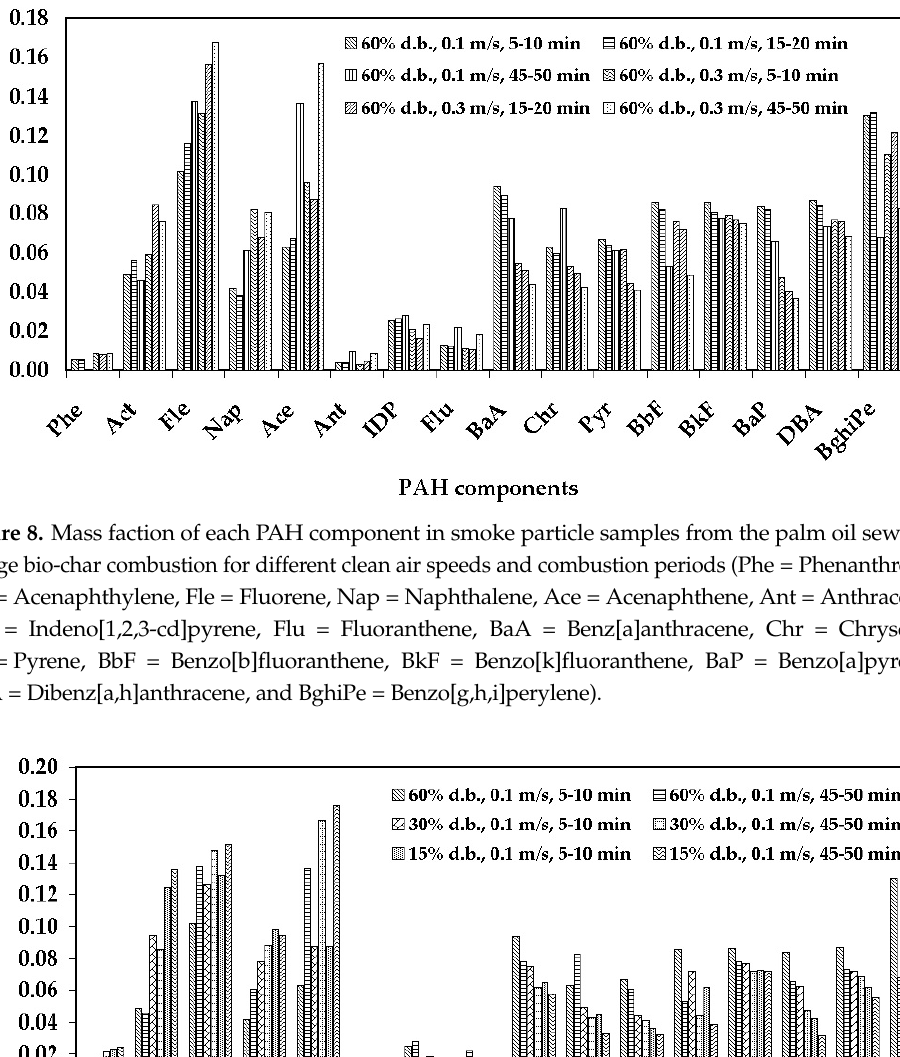
Figure 10. BaPTE value in the smoke particle samples from the POSS bio-char combustion for dif- ferent the clean air speeds and moisture contents . The relationship between the Tp value changed during the POSS bio-char combus- tion and with the bio-char moisture content. When substituting the a 0 , a 1 and a 2 coefficient values which were calculated by using the least-squares method in Equation (8), the equa- tion of the Tp value changed and could be written as shown in Equation (12). The experi- mental and predictable total BaPTE values of the POSS bio-char samples throughout the combustion period are presented in Table 2. The results showed that the total BaPTE value of the POSS bio-char burning was between 65.7 and 261.6. The increase in moisture con- tent of the POSS bio-char samples had a high influence on increasing the total BaPTE val- ues. Meanwhile, when increasing the clean air speed, the total BaPTE values decreased.